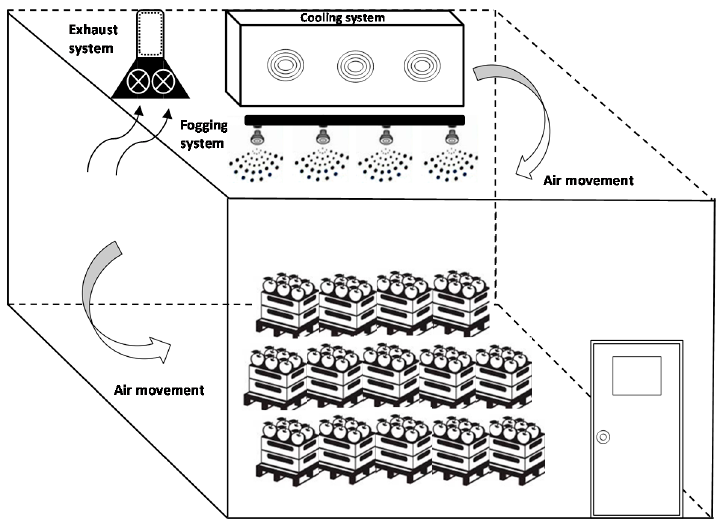
Figure 3. Schematic design of a fruit cold storage room with a fogging treatment.